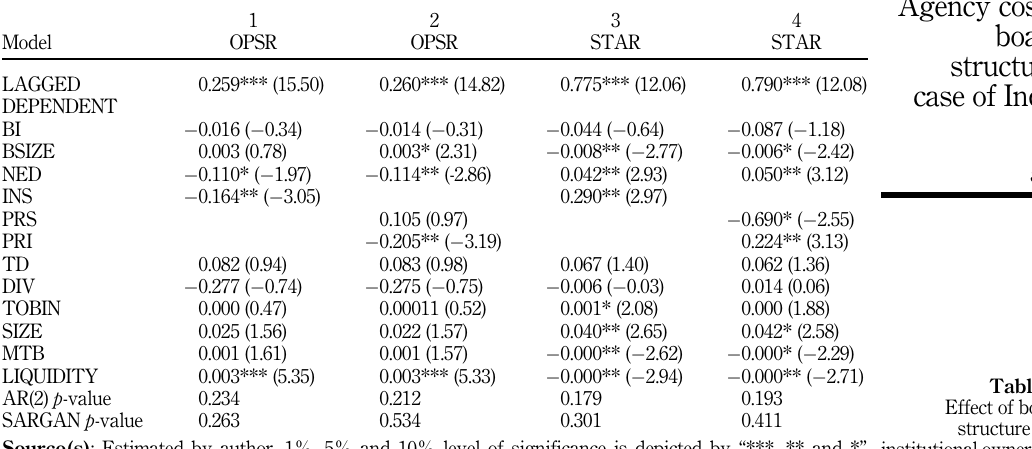
Table 3. Effect of